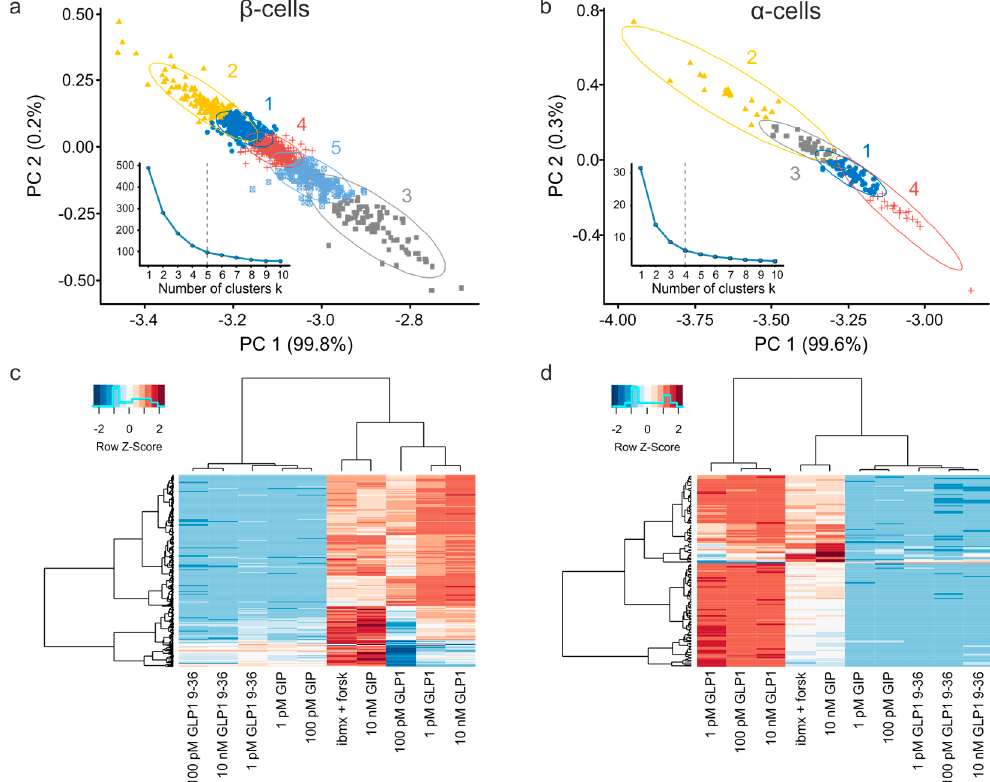
Figure 5. Cluster analysis of the incretin responsiveness of pancreatic islet cells. ( a , b ) k-means clustering of β - ( a ) and α -cell ( b ) populations. The linear contributions of individual factors into the first two principal components, PC 1 and PC2, are detailed in Table S2. Insets: Total within-cluster sum of squares depending on the cluster number. The plots were used to determine the optimal number of clusters. ( c , d ) Hierarchical clustering of pancreatic β - ( c ) and α -cell ( d ) populations alongside the incretin stimuli. “GLP9” denotes the inactive form of GLP-1, GLP-1 9–36. Z-score is the value relationship to the mean of the row, in the units of the standard deviation. Note a close per-cell association between the effects of lower concentrations of GIP (1 pM, 100 pM) and the inactive form of GLP-1 (9–36) as well as the effects of the high concentration of GIP (10 nM) and that of a direct stimulation of adenylate cyclase/inhibition of phosphodiesterase by forskolin and IMBX. The data is from six experiments, n = 10,294 cells.